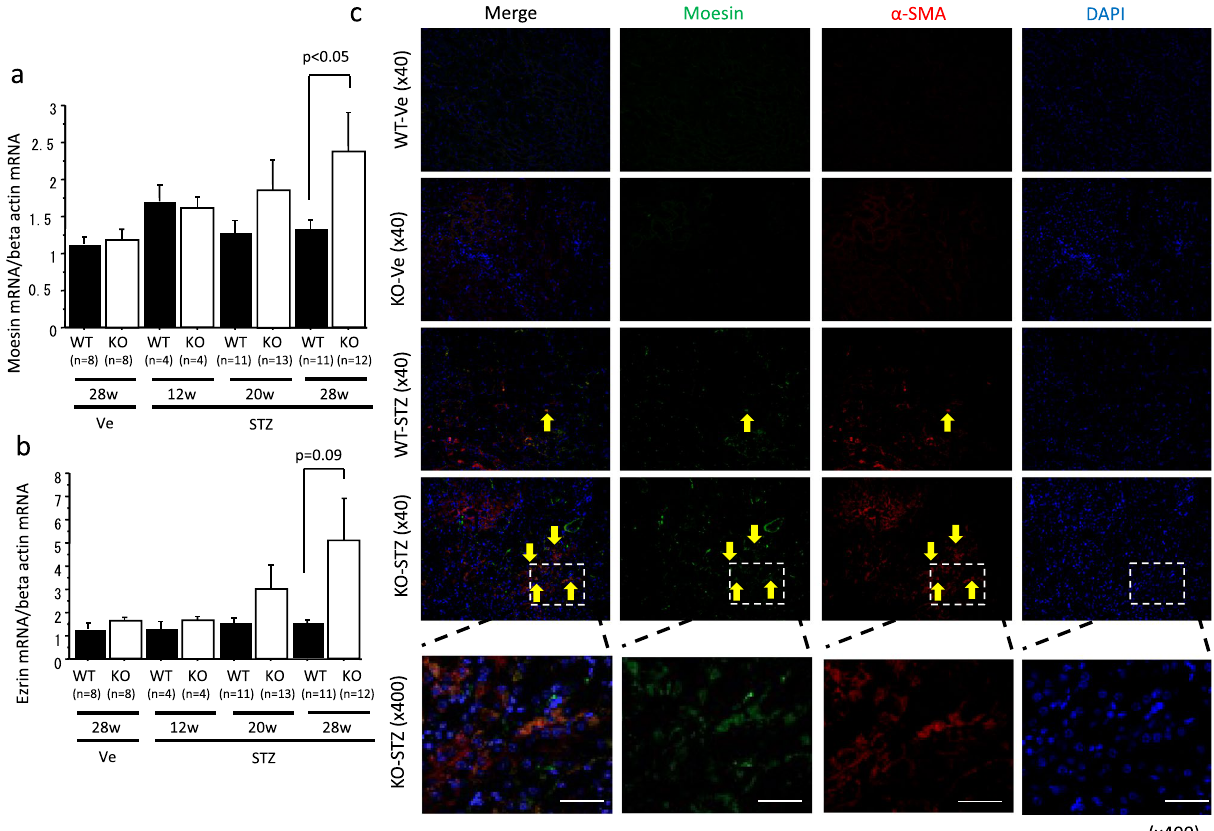
Figure 4. Moesin co-expressed on α-SMA-positive cell. Expression of moesin and ezrin was evaluated in the kidneys of the octn1 KO and WT mice with/without diabetes ( a , b ). Double positive cells of α-SMA and moesin were detected in octn1 KO diabetic mice .Yellow arrows indicates Moesin, α-SMA, and Moesin and α-SMA dual- positive cells. ( c ) KO, octn1 KO mice; WT, wild type mice; STZ, STZ injected mice; Ve, vehicle control.. The scale bar represents 100